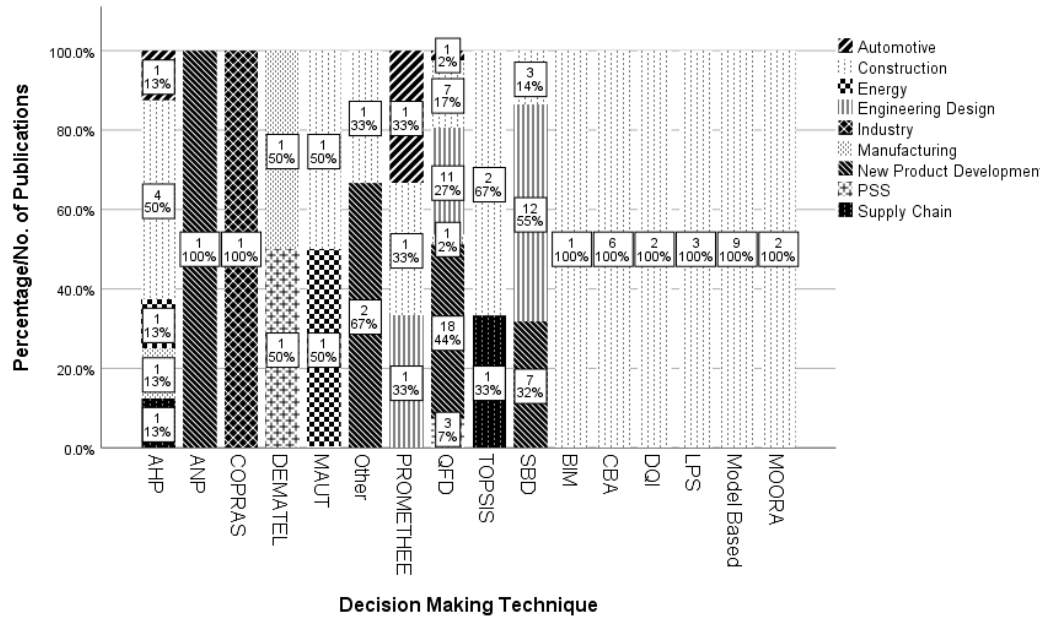
Figure 5. Reviewed decision-making techniques in design.